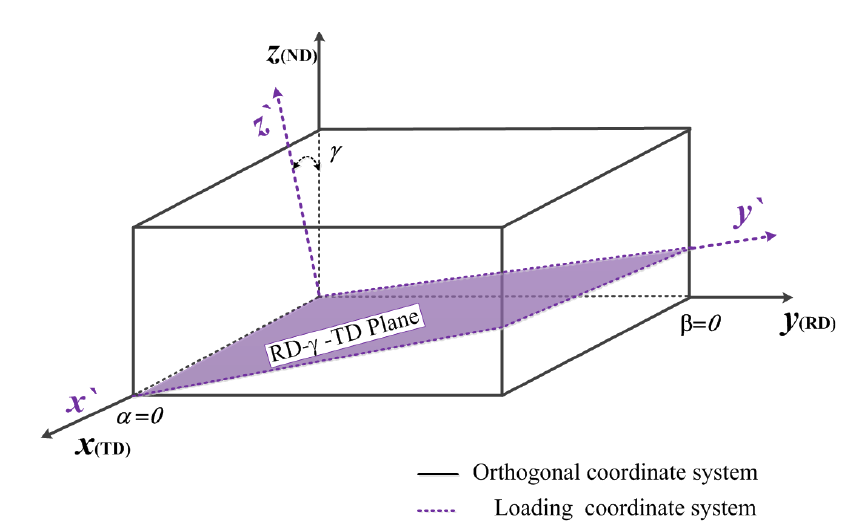
Figure 5. Relationship between the orthogonal and load coordinate systems of AA7050-T7451 .